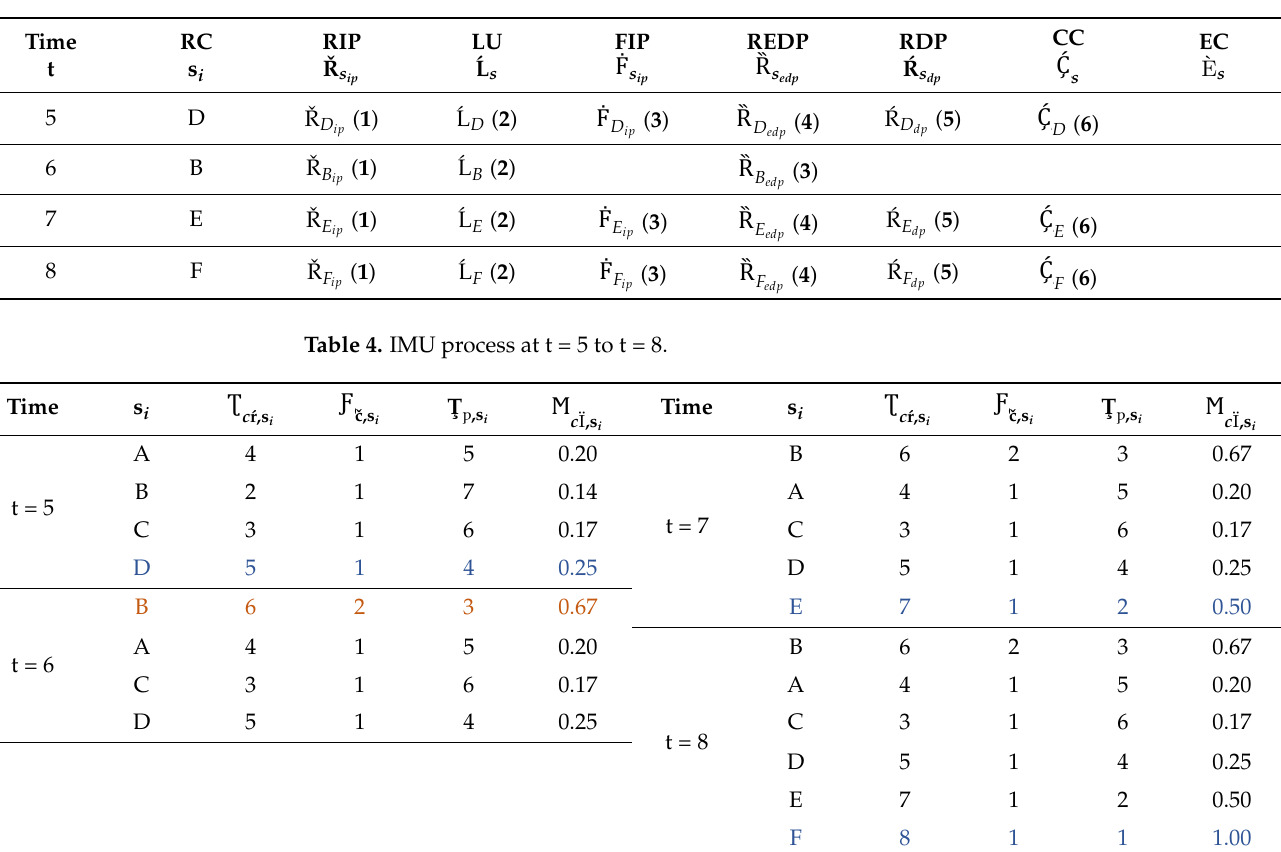
Table 3. Caching process at t = 5 to t = 8.